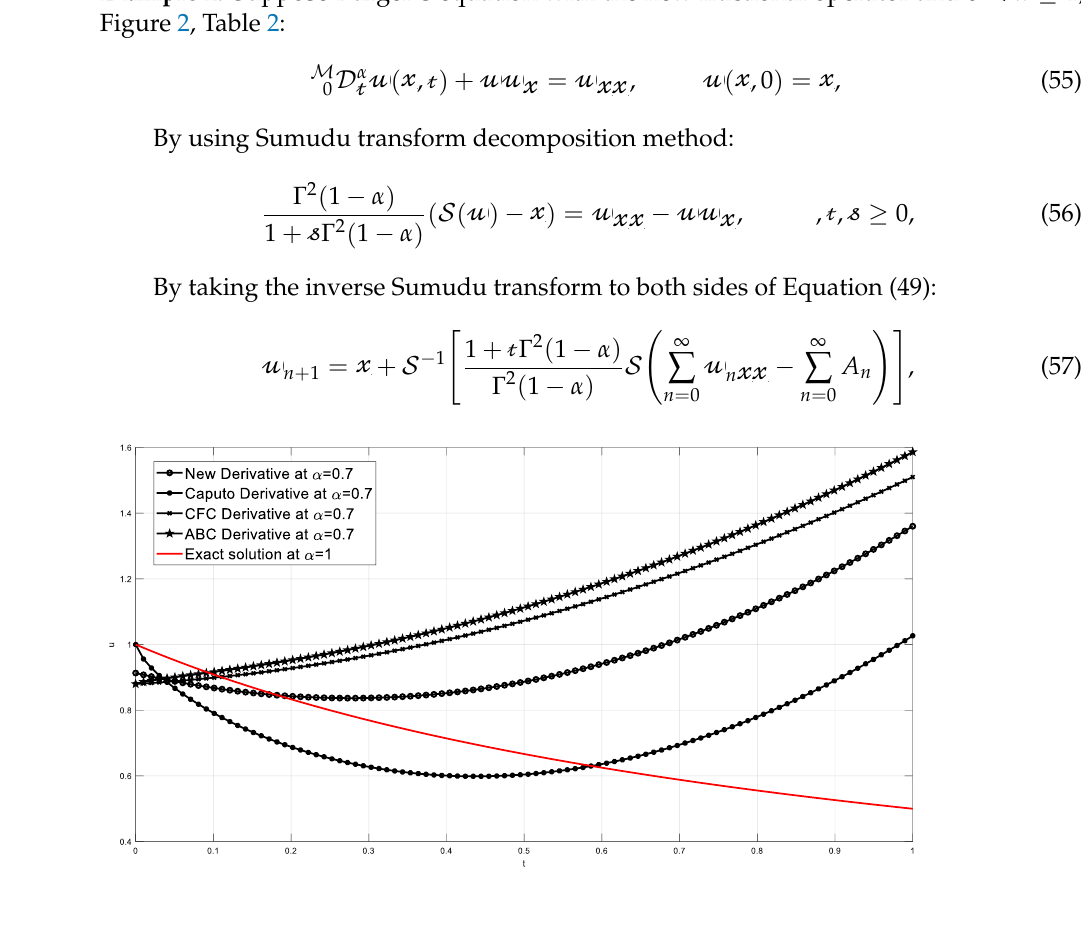
Table 2. The values of the approximate and exact solutions at 𝛼 = 1 and absolute error of Equa- tions (55), (59), (62), (64) and (66) at different values of 𝓉, 𝓍 .